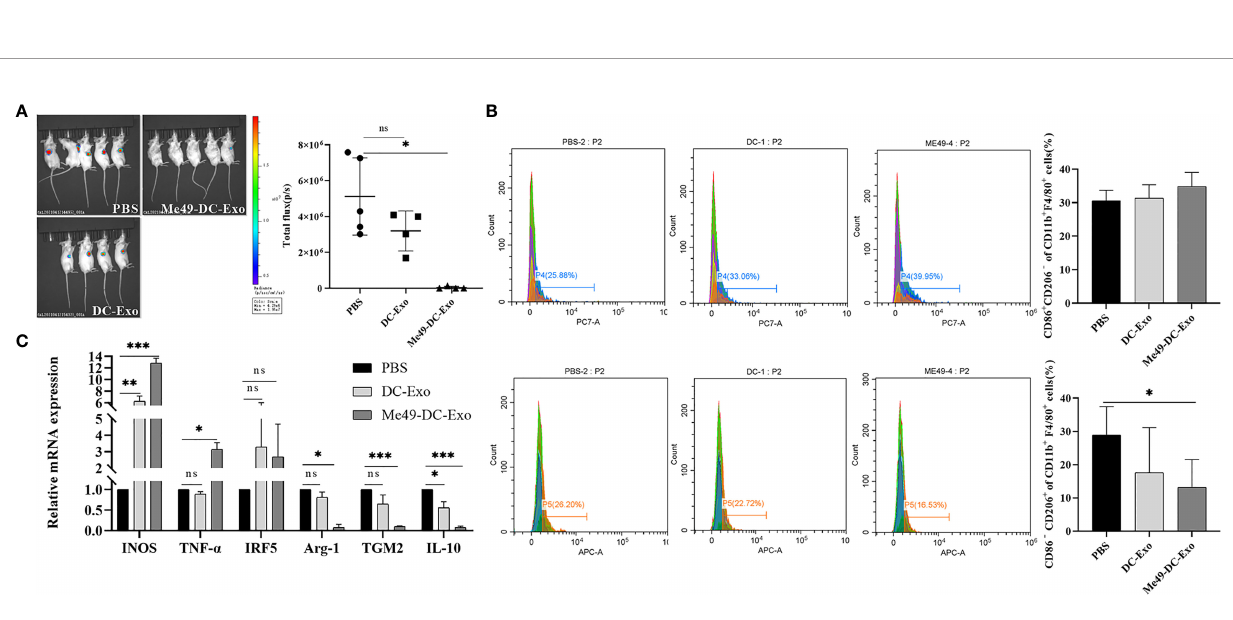
dye (green) and Hoechst dye (blue), respectively. Punctured green fl uorescence was noticed around the nuclei of macrophages treated with DC-Exo and Me49-DC-Exo ( Figure 3 ), demonstrating that these exosomes could be successfully internalized by RAW264.7 cells.